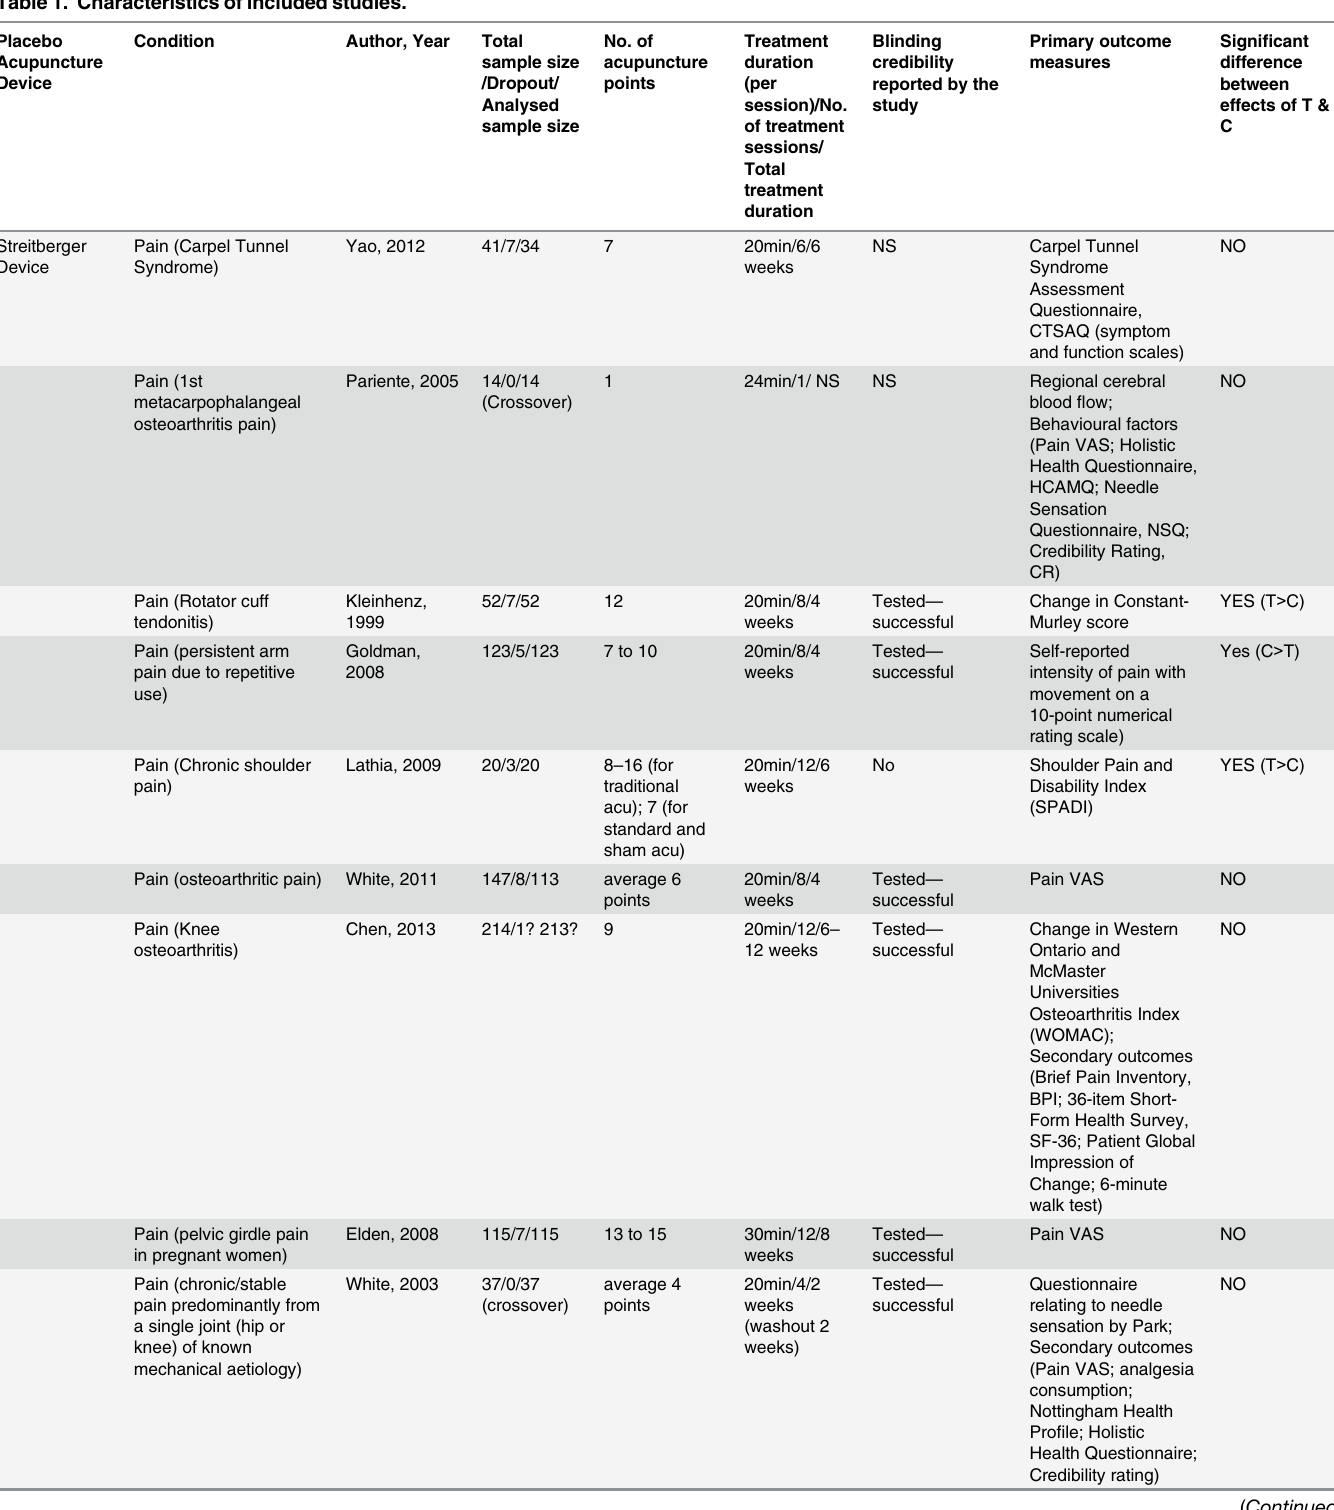
Table 1. Characteristics of included